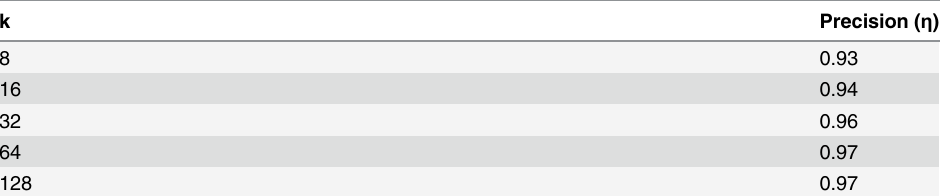
Table 1. Relationship between the k value and the precision of the system when fz = 1 and using smin = 0.5 (i.e. N =